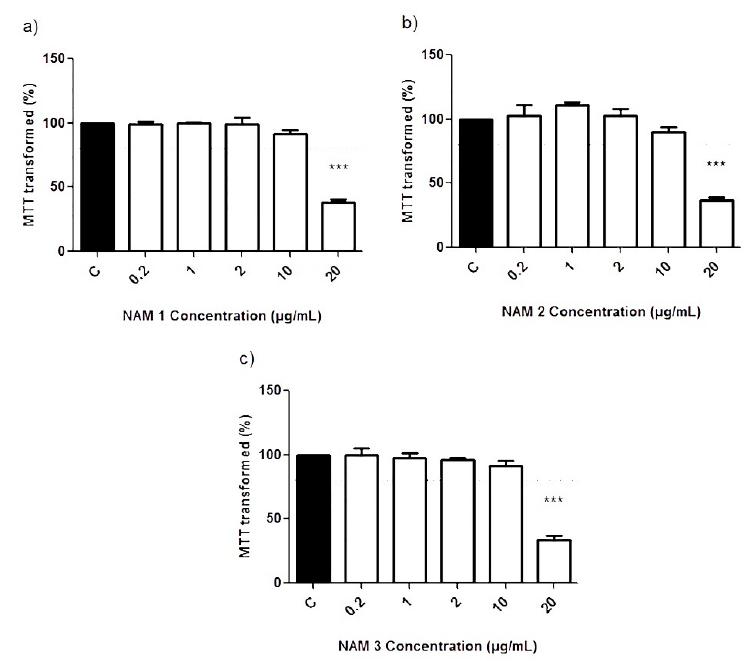
Figure 2. Evaluation of the cytotoxicity induced by the NPs copolymerized using DMAEMA and MMA. Cytotoxicity was determined by the percentage of MTT transformed in the NIH 3 T 3 cells exposed to concentrations from 0.2 to 20 µ g/mL of NAM1 ( a ), NAM2 ( b ) and NAM3 ( c ). Data are expressed as mean ± SEM (n = 5). *** p < 0.001 vs. the vehicle-treated cells (by Kruskal–Wallis, followed by Dunn’s test).